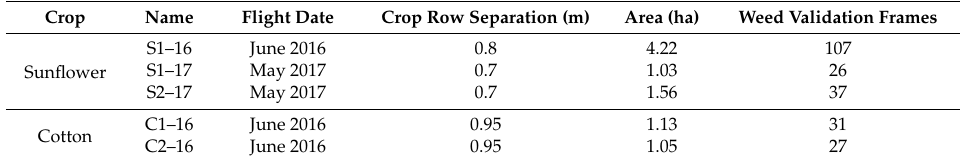
Table 1. Study fields and UAV-flight data.